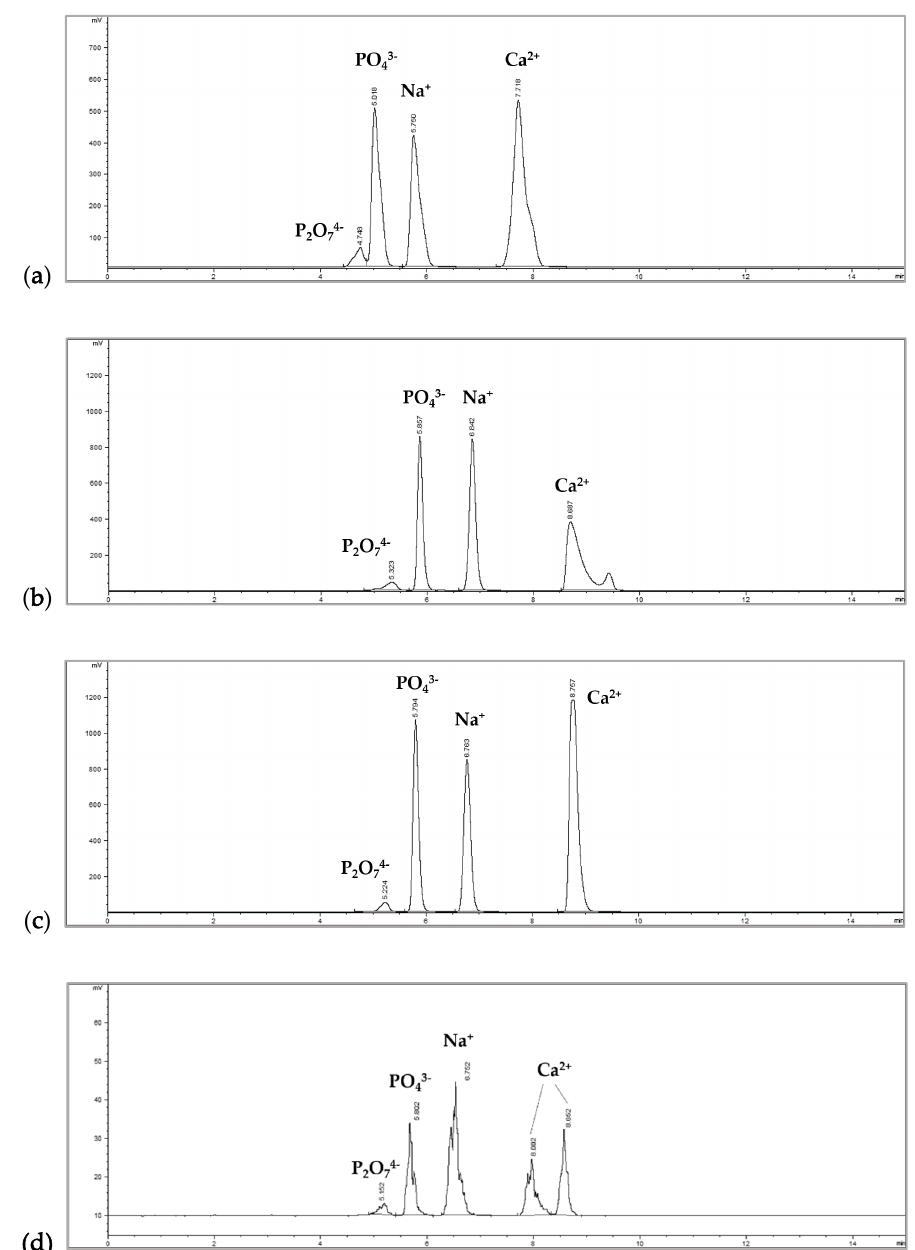
Figure 2. HPLC chromatograms: ( a ) condition 1 with Agilent XDB-C18 at an isocratic mobile phase of acetonitrile (ACN):water (0.7% trifluoroacetic acid (TFA), 5 mM heptafluorobutyric acid (HFBA)) = 2:98; ( b ) condition 2 with YMC Triart-C8 at an isocratic mobile phase of ACN:water (0.7% TFA, 5 mM HFBA) = 2:98; ( c ) condition 3 with YMC Triart-C8 at an isocratic mobile phase of ACN:water (0.7% TFA, 5 mM HFBA) = 9:91; ( d ) after approximately 48 hours of repeated measurements with condition